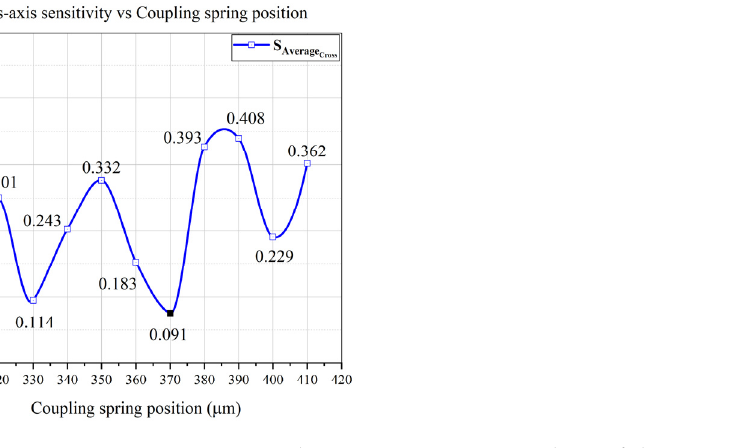
Figure 9. Cross-Axis Sensitivity vs. Coupling Spring Position Analysis of the Designed MEMS Gy- roscope.